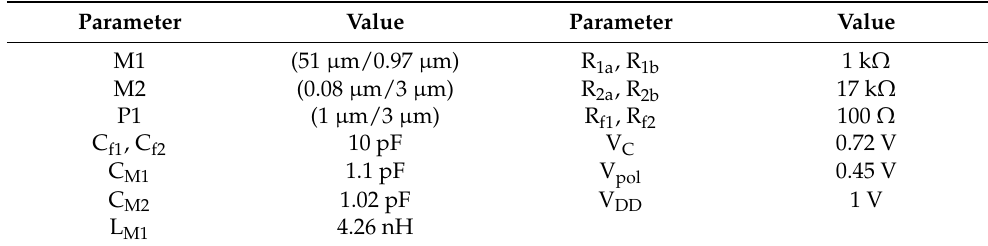
Figure 12. Layout of the current-reuse feedback amplifier used in the WuR. Table 2. Summary of component values for the tuned RFED with feedback amplifier WuR.